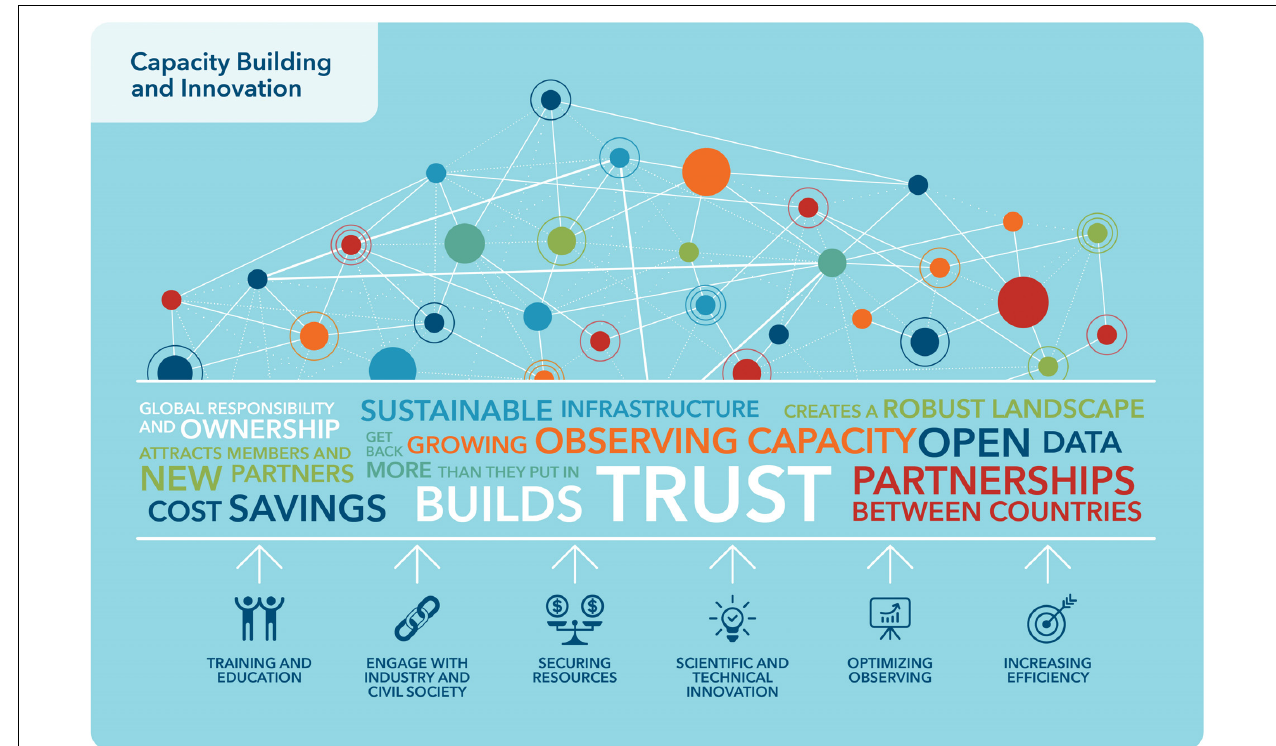
FIGURE 11 | Capacity building and innovation. Activities related to capacity building and innovation should take place across the system and should support and encourage collaboration between the system